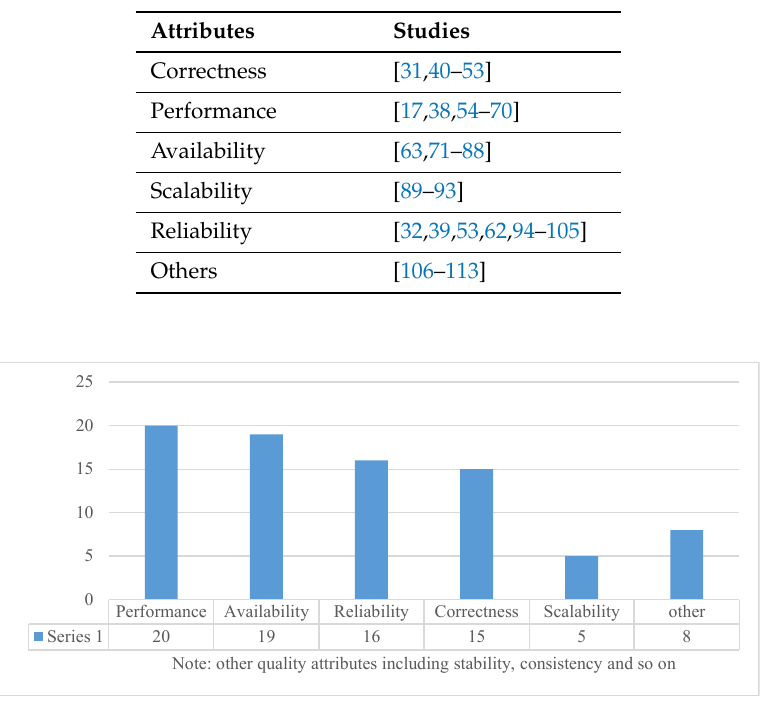
Figure 7. The quantity distribution of the quality